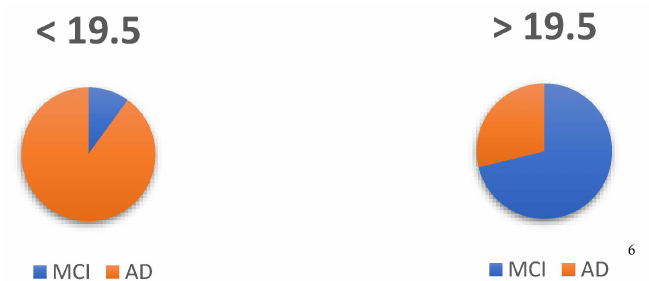
Figure 5. Assignment of subjects: MCI and AD. 6 Number of subjects . According to diagnosis and cut-off